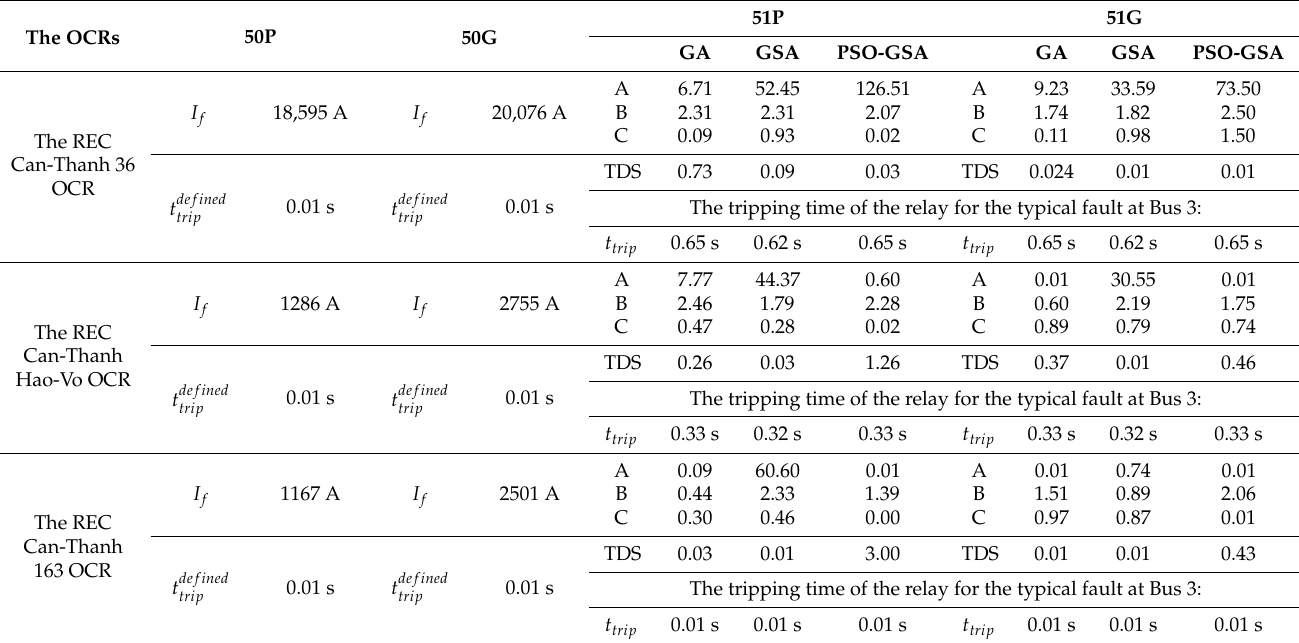
Table 5. Optimal protection coordination results of the OCRs in Scenario 2 and their tripping time when the fault is at Bus 3. The OCRs